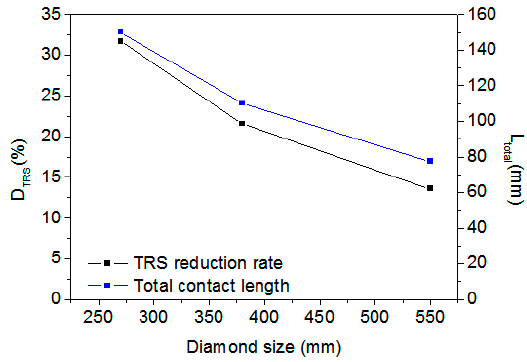
Figure 8. Percent TRS reduction D TRS and total diamond boundary length L total versus diamond size.